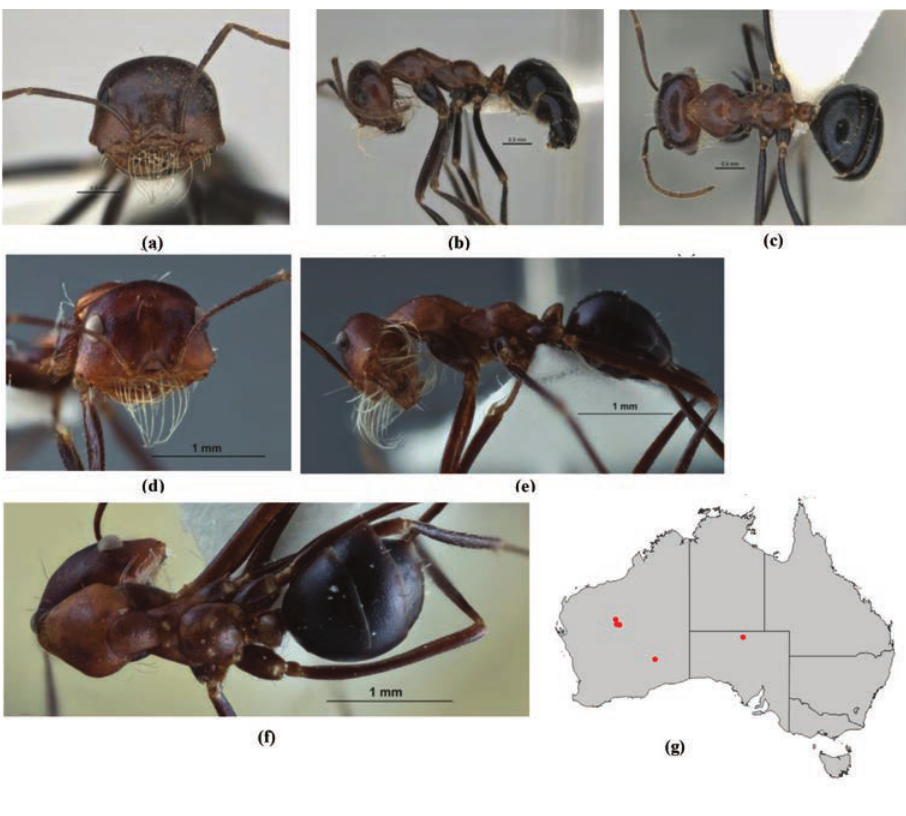
Figure 84. Melophorus pelorocephalus sp. n.: major worker paratype (JDM32-004898–bottom ant) frons ( a ), profile ( b ) and dorsum ( c ); minor worker holotype (JDM32-004714–top ant) frons ( d ), pro- file ( e ) and dorsum ( f ); distribution map for the species ( g ). Low resolution scale bars: 1 mm ( a–c ). and mesopleuron moderately shining and shagreenate throughout; anterior mesosoma in profile broadly convex; erect pronotal setae absent; in profile, metanotal groove shal- low, broadly V or U-shaped; propodeum matt or with weak sheen and finely striolate; propodeum smoothly rounded or with indistinct angle; propodeal dorsum and decliv- ity confluent; erect propodeal setae always absent; appressed propodeal setulae short, separated by more than own length and inconspicuous; propodeal spiracle situated nearer to midpoint of propodeum than to its declivitous face, and shorter (length < than 0.50 × height of propodeum). Petiole . In profile, petiolar node narrowly conical, vertex blunt, directed posteriad; in full-face view, shape of petiolar node tapered with blunt vertex; node shining and smooth with vestigial sculpture. Gaster . Gaster weakly shining with indistinct shagreenation; pilosity of first gastral tergite consisting of well- spaced short, inconspicuous, appressed setae, erect setae (present in at least some work- ers) confined to margin of sclerite. General characters . Colour of foreparts tan, head darker, legs and gaster dark